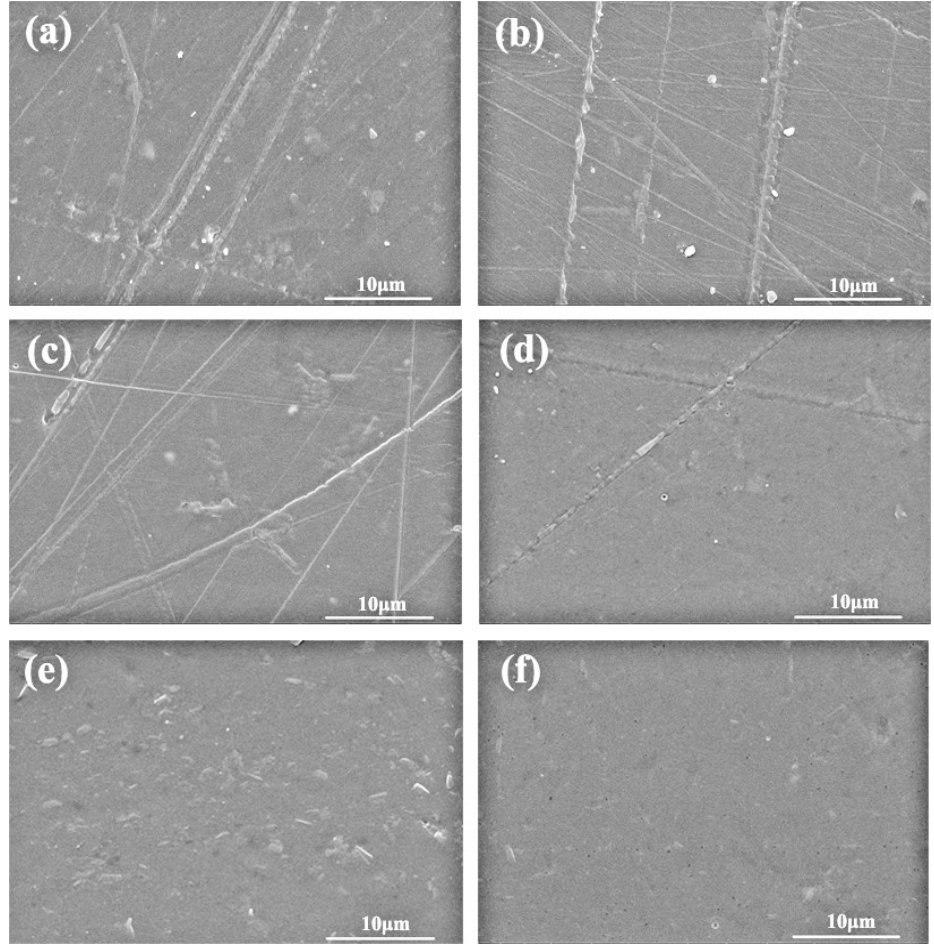
Figure 5. SEM images of SPI-based films: ( a ) 93% graphene aqueous dispersion; ( b ) 74% graphene aqueous dispersion; ( c ) 56% graphene aqueous dispersion; ( d ) 37% graphene aqueous dispersion; ( e ) 19% graphene aqueous dispersion; ( f ) the pure SPI film.